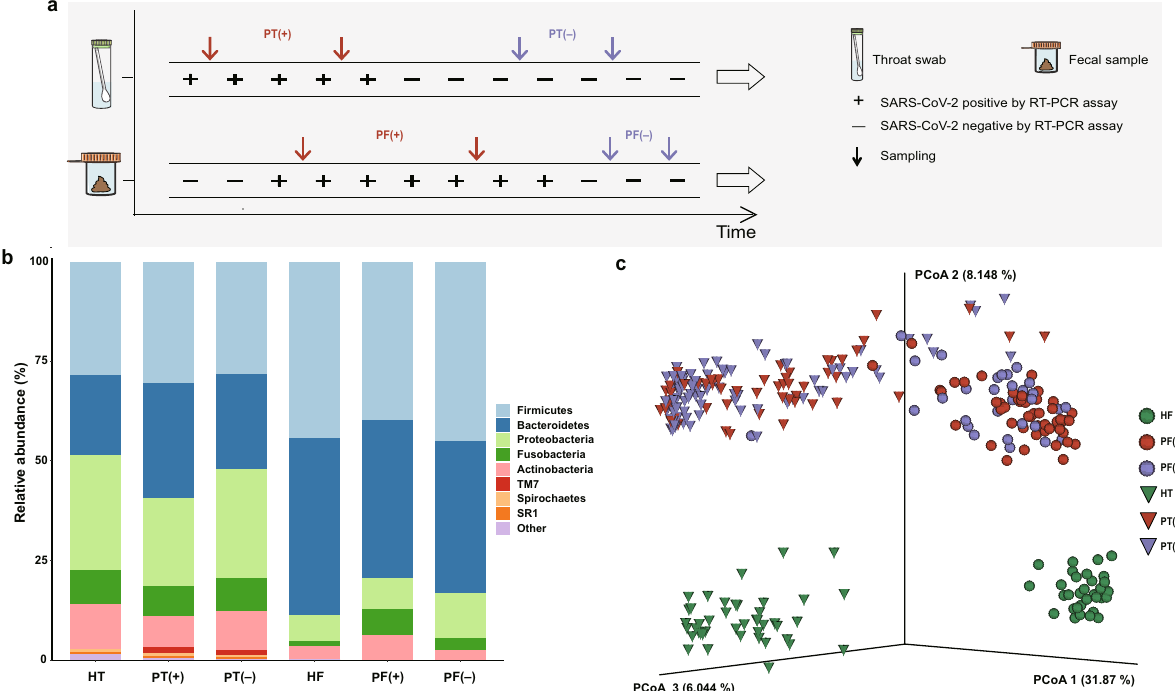
Fig. 1 The study design and variations of the oral and gut microbiota in COVID-19 patients. a Graphic representation of study design and sample collection. PT( + ), throat swab samples from COVID-19 patients during the positive viral RNA test period; PT( − ), throat swab samples from COVID-19 patients during the negative viral RNA test period; PF( + ), fecal specimens from COVID-19 patients during the positive viral RNA test period; PF( − ), fecal specimens from COVID-19 patients during the negative viral RNA test period. b Bacterial composition at the phylum level among groups. Sample size ( n ) for each group: HT, n = 44; PT( + ), n = 52; PT( − ), n = 88; HF, n = 32; PF( + ), n = 50; PF( − ), n = 31. HT, throat swab samples from the healthy controls; HF, fecal specimens from the healthy controls. c PCoA plot based on the unweighted UniFrac distance depicting differences in the bacterial community among